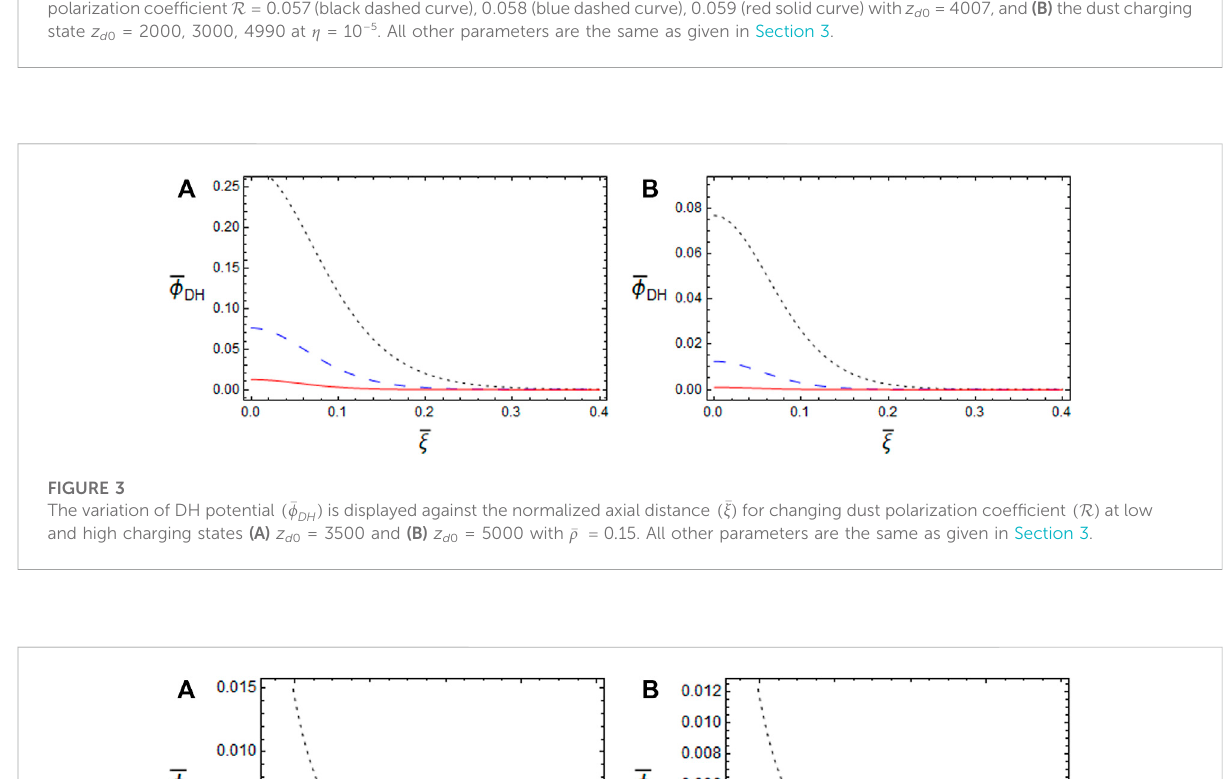
(cid:2) ϕ ) is FF (cid:2) ξ for varying (A) the